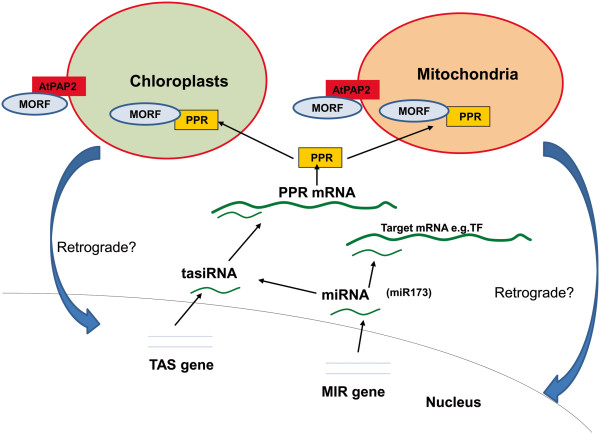
A model on the relationship of AtPAP2 and sRNAs. Overexpression of AtPAP2 protein in chloroplasts and mitochondria affect the physiology of these two energy-generating organelles, which may lead to a change in the miR173-tasiRNAs-PPR/TPR network.